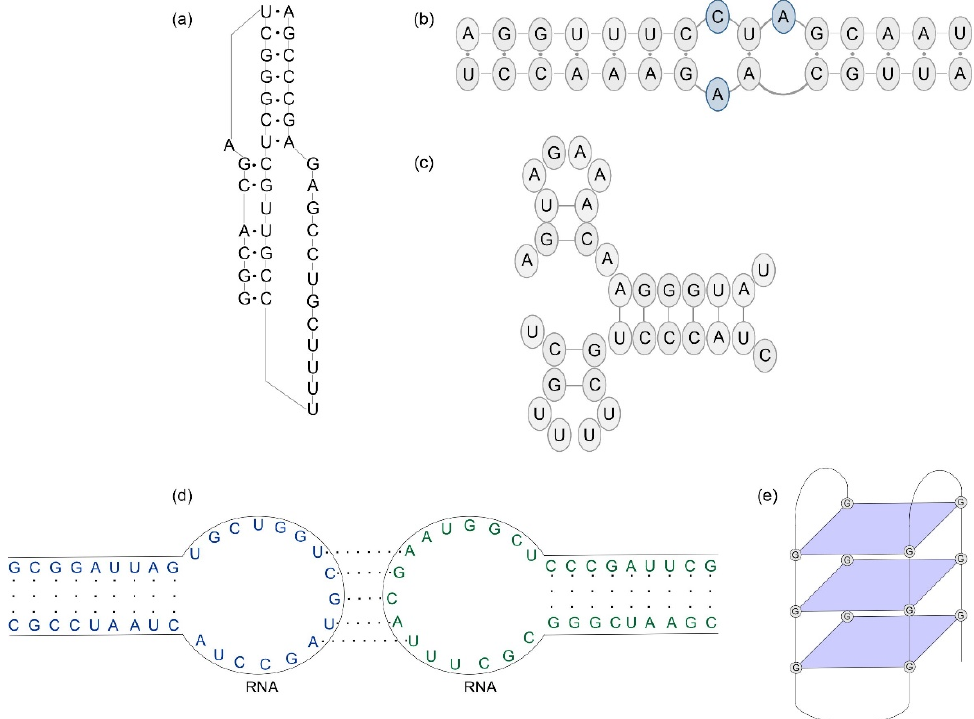
Figure 3. Examples of structural motifs found in the viral genomes, ( a ) pseudoknot, ( b ) panhandle, ( c ) corkscrew conformation, ( d ) kissing-loops, and ( e ) G-quadruplex.